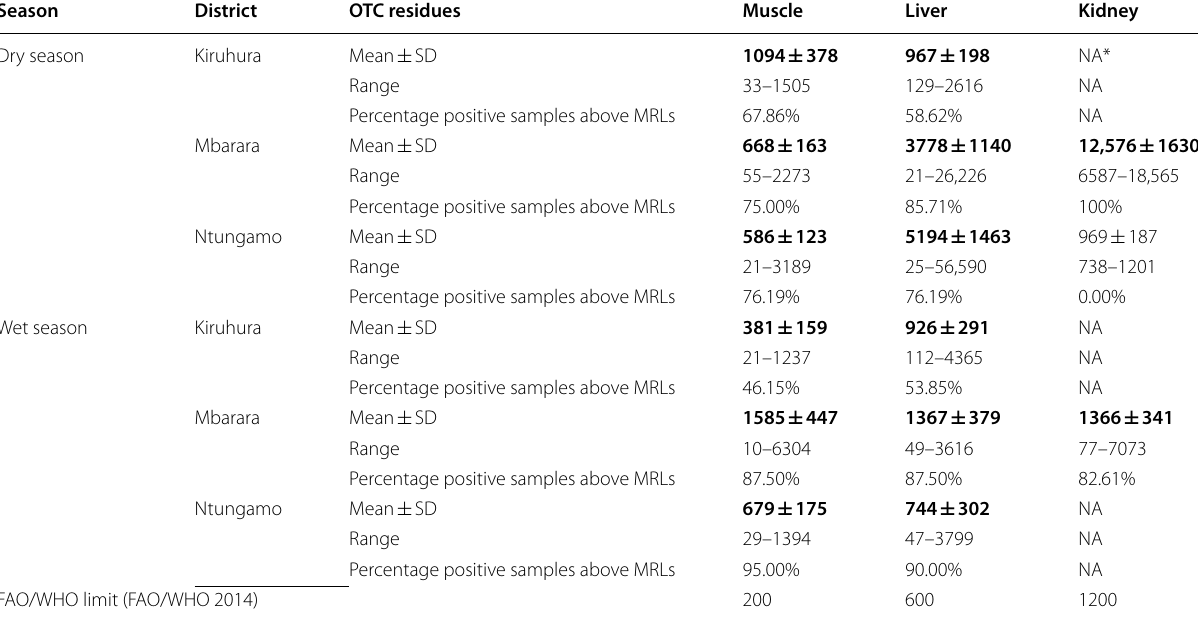
SD: Standard deviation, MRLs: Maximum residue limits. *NA